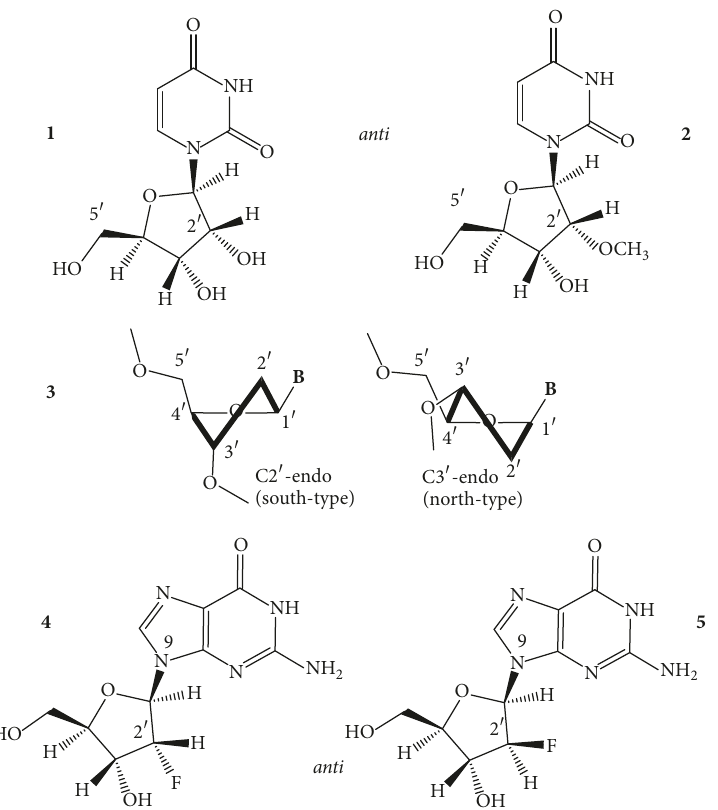
Figure 9: Structures of the anti ribo- ( 1 ) and the 2 󸀠 -O-methylribouridines ( 2 ); the C2 󸀠 -endo (S-type) and C3 󸀠 -endo (N-type) sugar puckers ( 3 ); the 2 󸀠 -fluoro-2 󸀠 -deoxy ribo furanosylguanine ( 4 ); and 2 󸀠 -fluoro-2 󸀠 -deoxy- arabino furanosylguanine ( 5